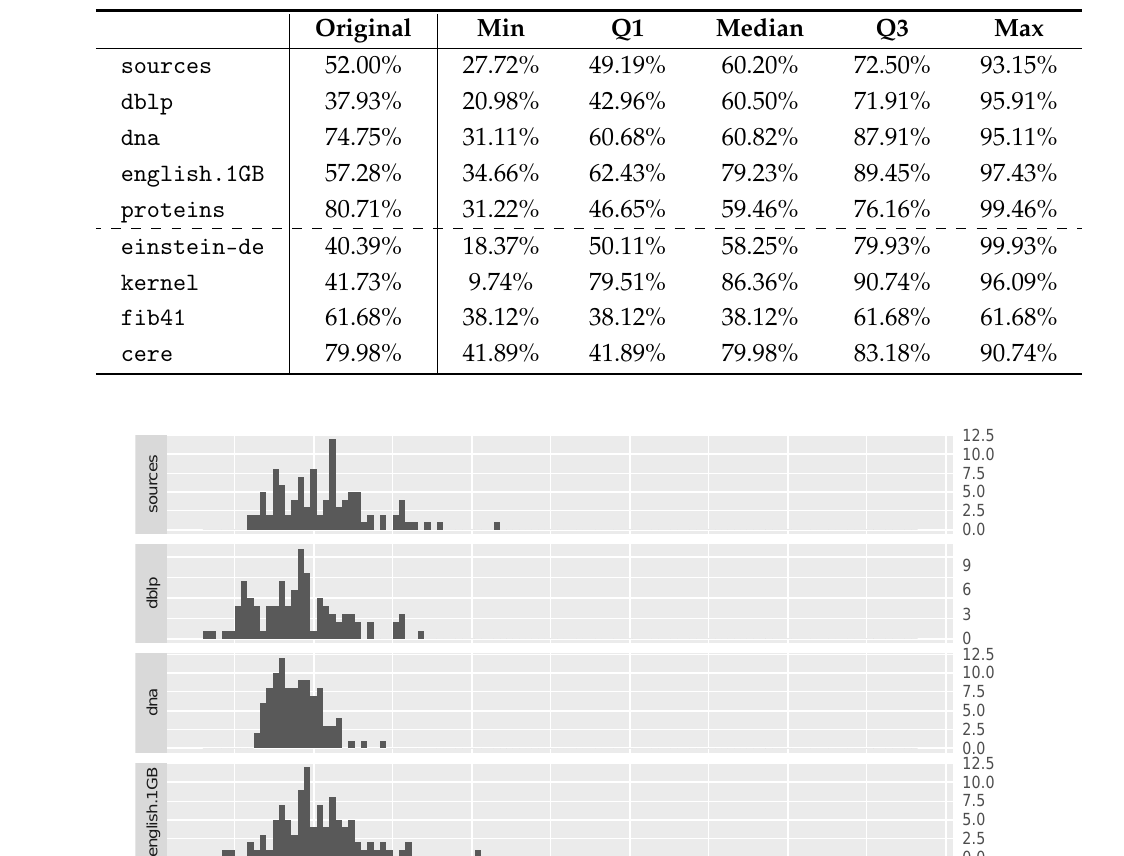
Table 3. Longest Lyndon factors (in percentage of the total length of the string) for random permuta- tions of the alphabet. Column 1 shows the longest factor of the original alphabet. Columns 3 and 7 show the minimum and maximum longest factors obtained with 100 random permutations of the alphabet. Columns 4, 5 and 6 show the first quartile (Q1), the median and the third quartile (Q3) of the distribution.